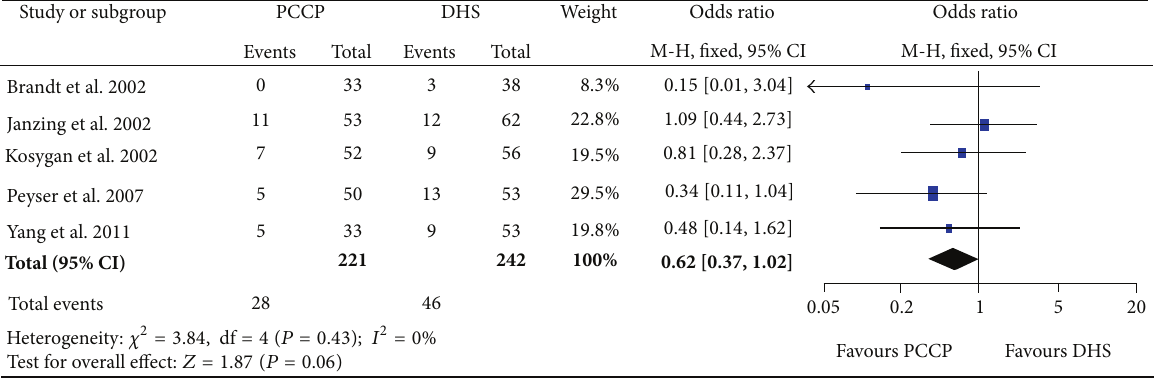
Figure 9: Comparison of mortality between PCCP and DHS.